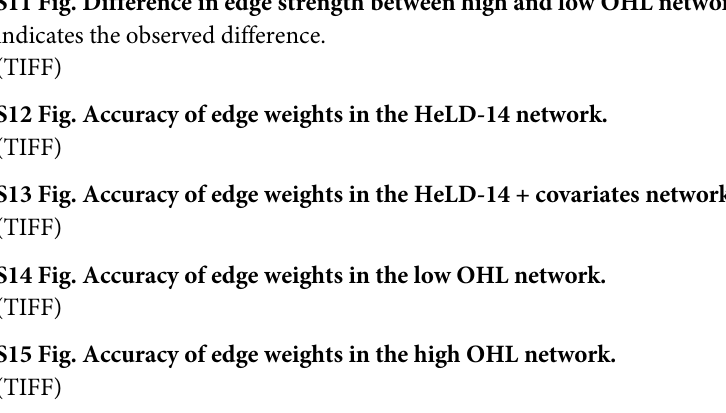
S11 Fig. Difference in edge strength between high and low OHL networks. Red triangle indicates the observed difference. (TIFF) S12 Fig. Accuracy of edge weights in the HeLD-14 network. (TIFF) S13 Fig. Accuracy of edge weights in the HeLD-14 + covariates network. (TIFF) S14 Fig. Accuracy of edge weights in the low OHL network. (TIFF) S15 Fig. Accuracy of edge weights in the high OHL network.